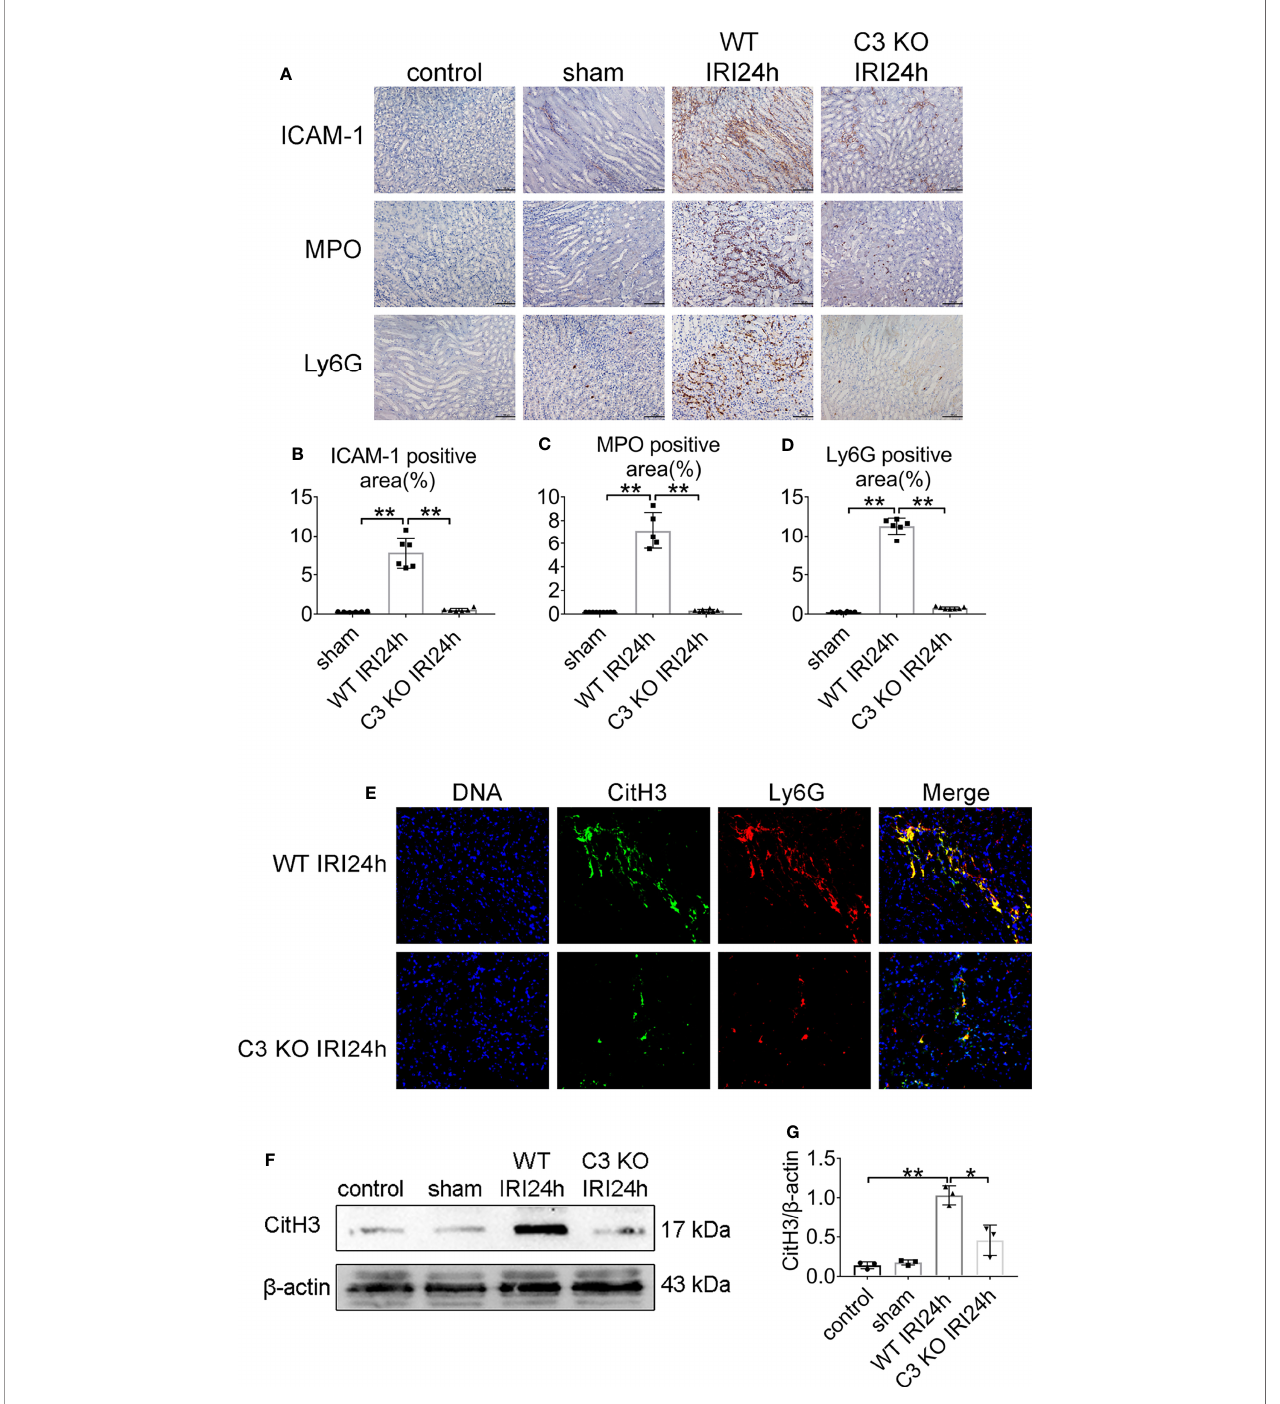
FIGURE 7 | NET formation decreased in C3 de fi cient mice. (A) Histology of IRI kidney in the indicated treatments. ICAM-1 immunohistochemistry (Row 1). MPO immunohistochemistry (Row 2). Ly6G immunohistochemistry (Row 3). Scale bar = 100 m M, n = 5 – 6/group. The percentage of positive neutrophil staining in 10 non- overlapping fi elds was quanti fi ed using Image J software. (B) ICAM-1-positive area. (C) MPO-positive area. (D) Ly6G-positive area of sections from kidneys harvested for 24 h in WT and C3 KO mice. (E) Representative overlay images of NETs staining in WT and C3 KO mice 24 h after IRI, DAPI (blue), CitH3 (green), and Ly6G (red). (F) Immunoblotting analysis of CitH3 expression in WT and C3 KO mouse kidneys 24 h after IRI. (G) Quantitative analysis was analyzed by normalization to b -actin expression.*P <0.05, **P <